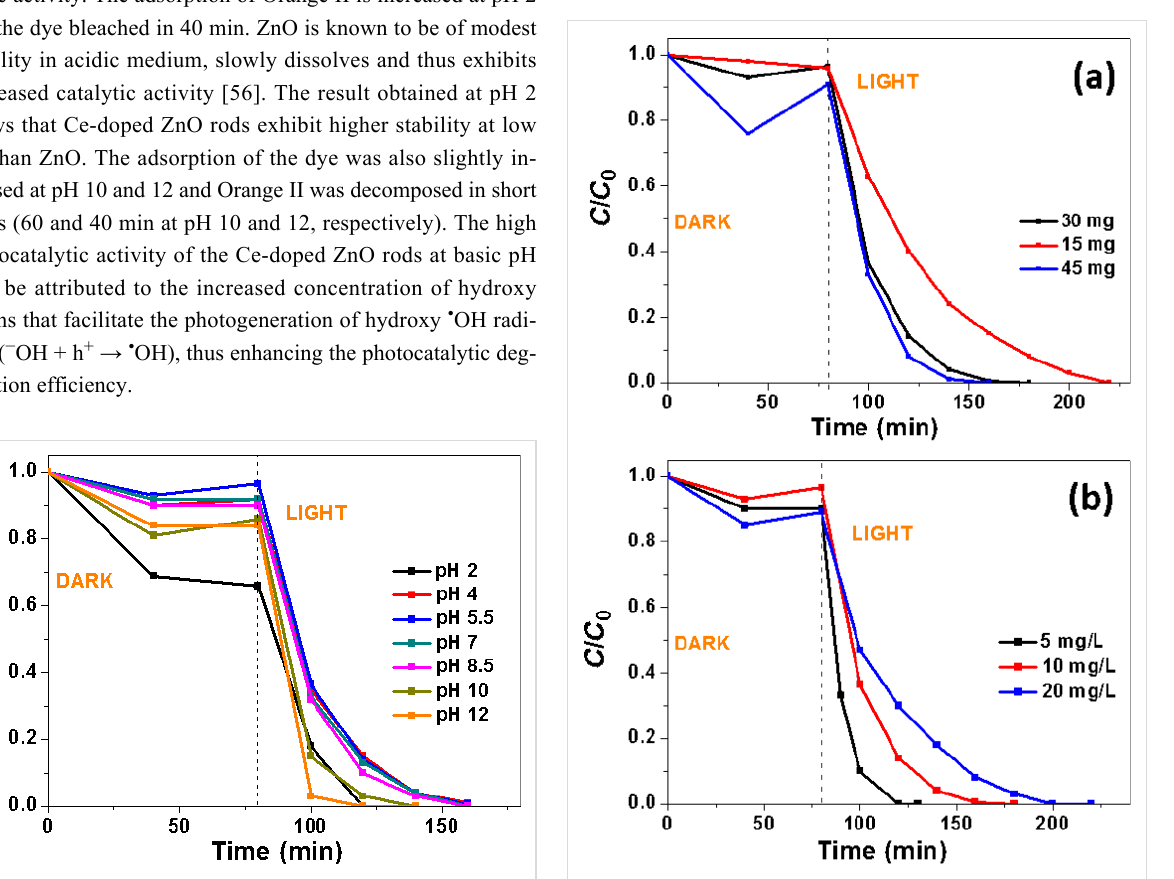
Figure 10: Effects of (a) the catalyst amount and (b) the dye concen- tration on the photocatalytic activity of 5% Ce-doped ZnO